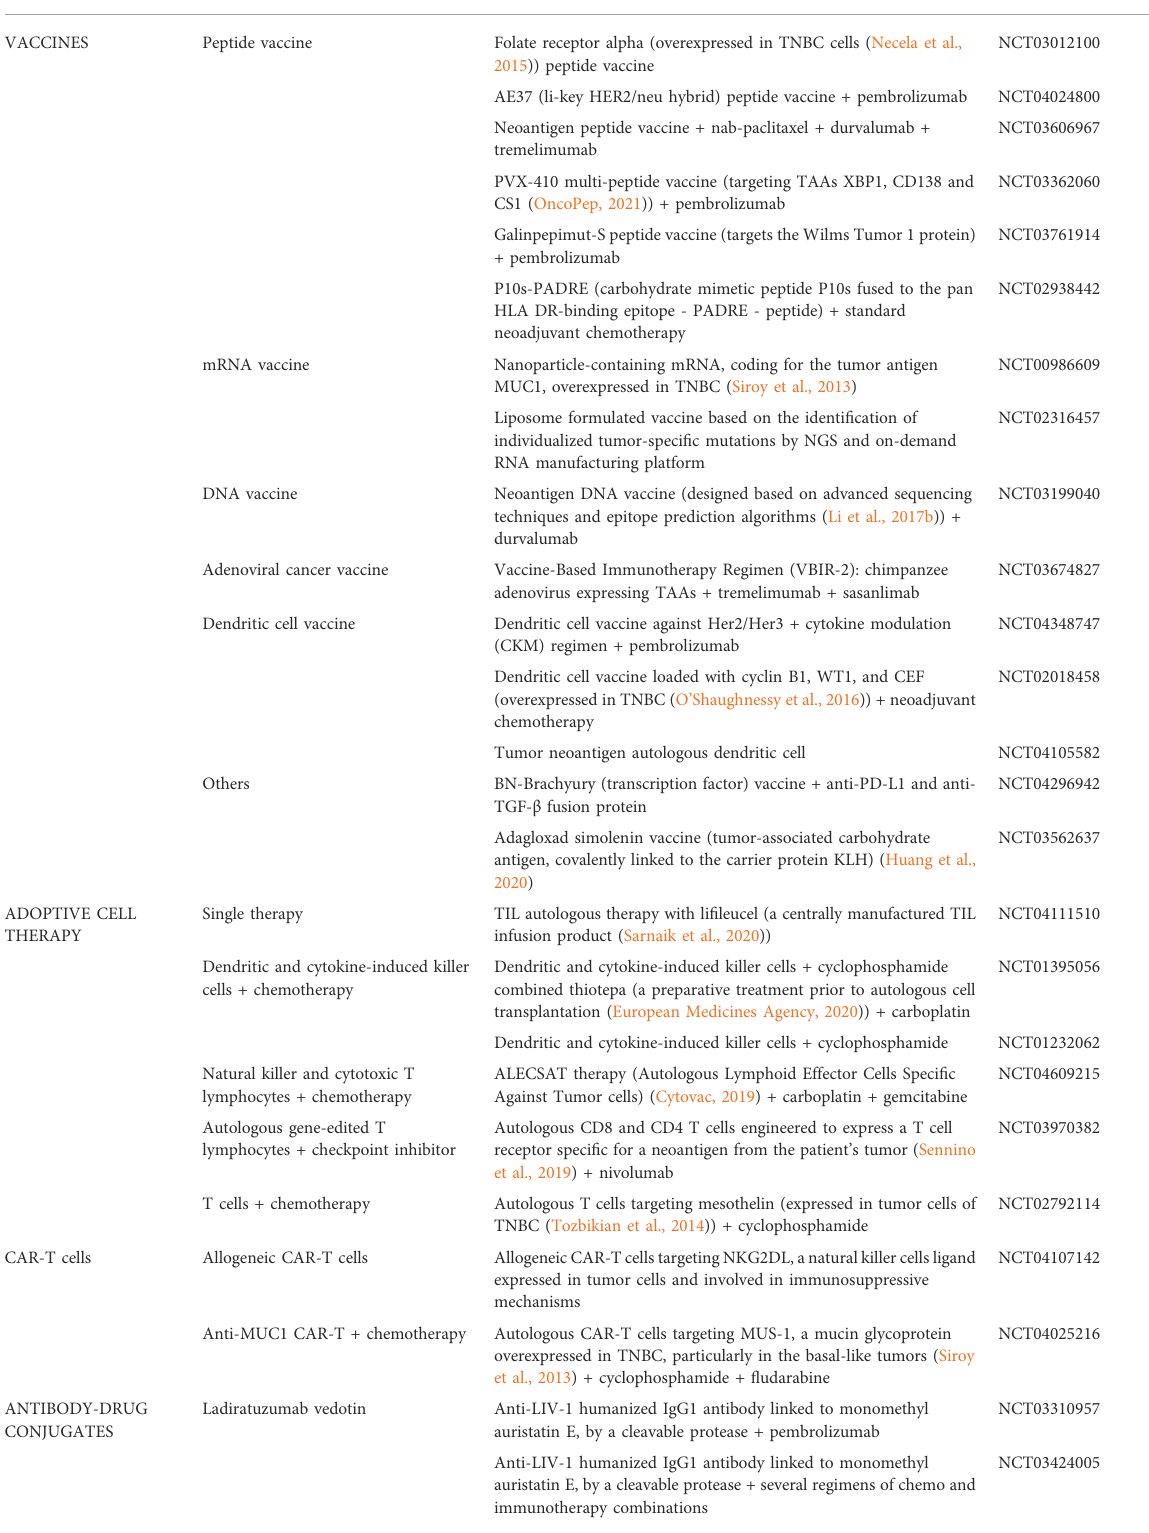
TABLE 3 Alternative immunotherapeutic approaches against